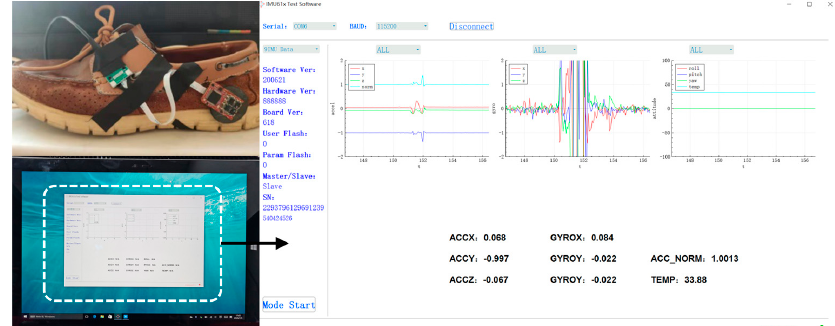
Figure 7. Walking experiments devices.